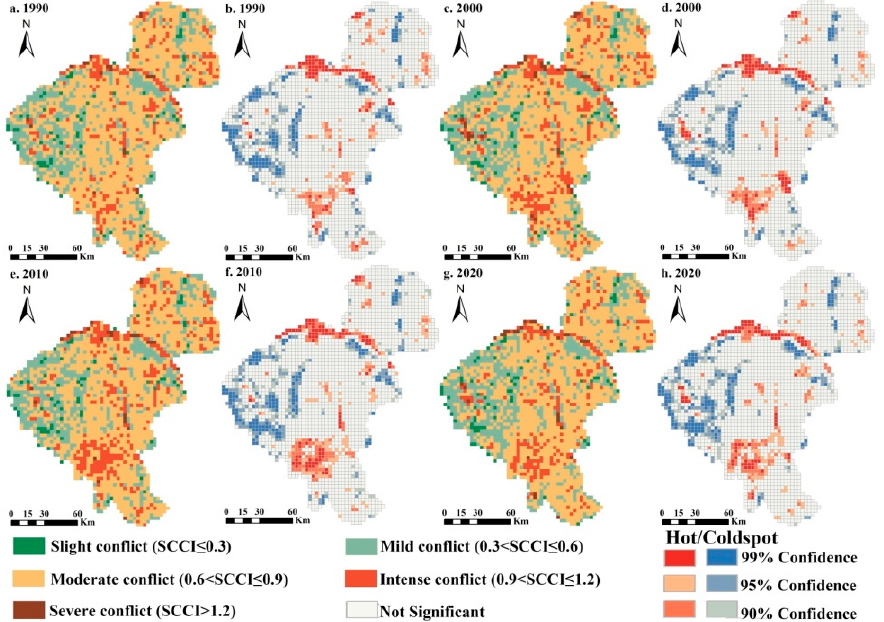
Figure 6. Spatio-temporal patterns of land use conflict in Changchun City from 1990 to 2020. ( a , c , e , g ) The evaluation results of land use conflict in 1990, 2000, 2010, and 2020, respectively; ( b , d , f , h ) the hotspot analysis results of land use conflict in 1990, 2000, 2010, and 2020,